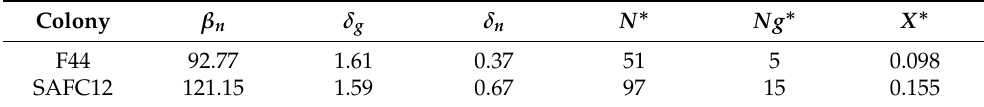
Table 3. Best fitting parameters ( β n , δ g , δ n ) of model (9) and (10) for colonies F44 and SAFC12. The fixed parameters are e = 2.42, d g = 0.00028, d w = 0.0025, and β g = 33. Moreover, the